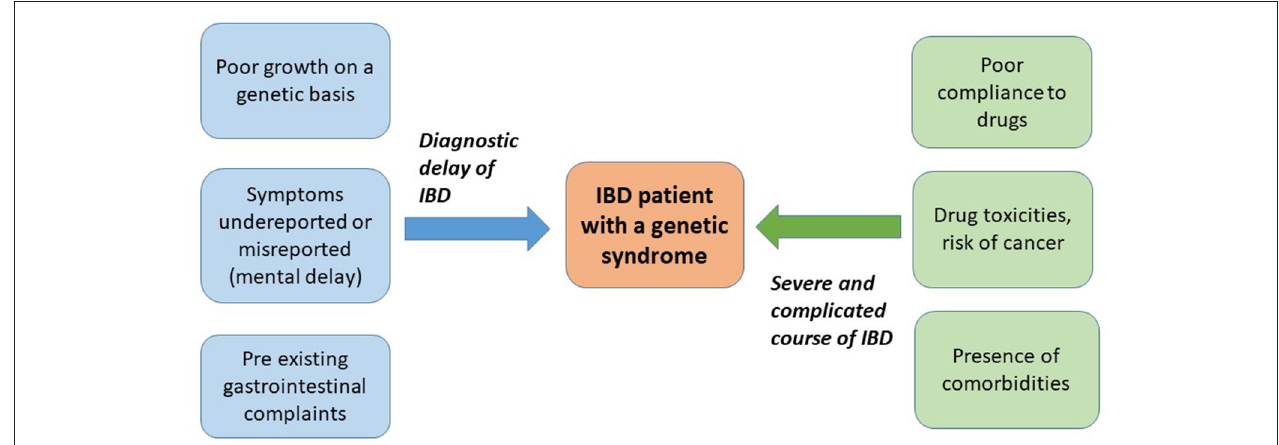
FIGURE 1 | Peculiarities of inflammatory bowel disease (IBD) diagnosis and course in the context of a genetic